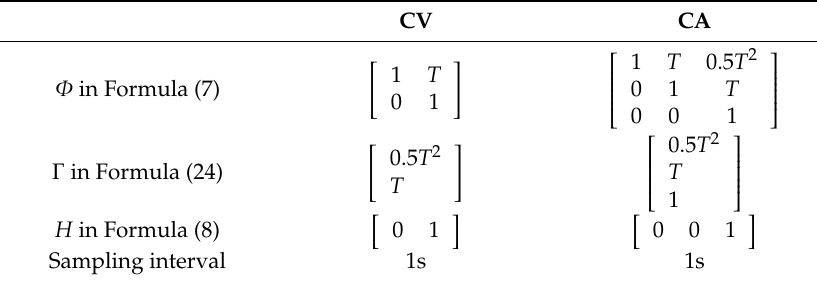
Table 1. Default parameter settings of the Kalman filter at time T .